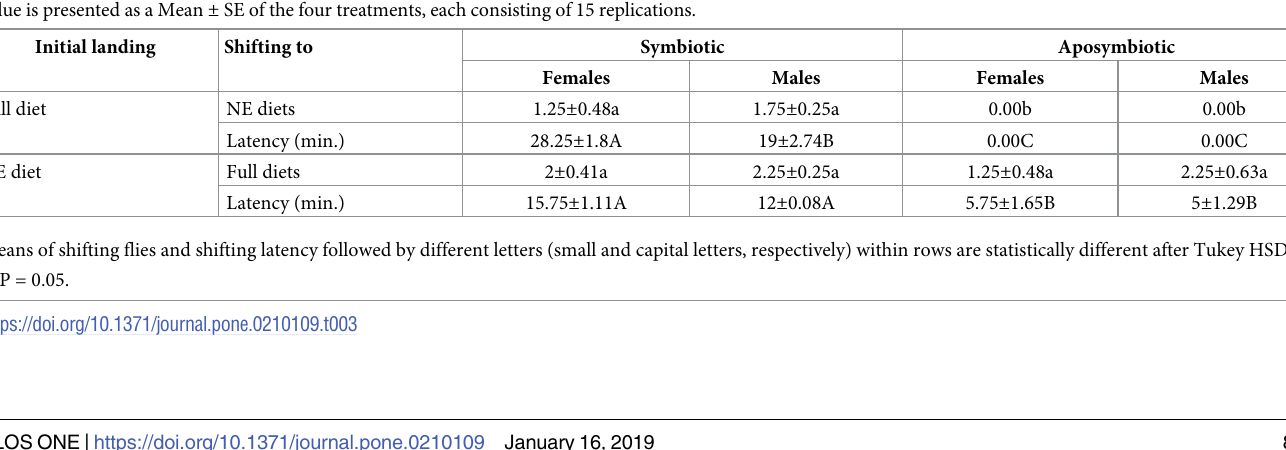
Table 3. Switching behavior of B . dorsalis as influenced by diet quality. The analysis involved only treatments with different diet types regardless the drop size. Each value is presented as a Mean ± SE of the four treatments, each consisting of 15 replications. Initial landing Shifting to Symbiotic Aposymbiotic Full diet NE diets